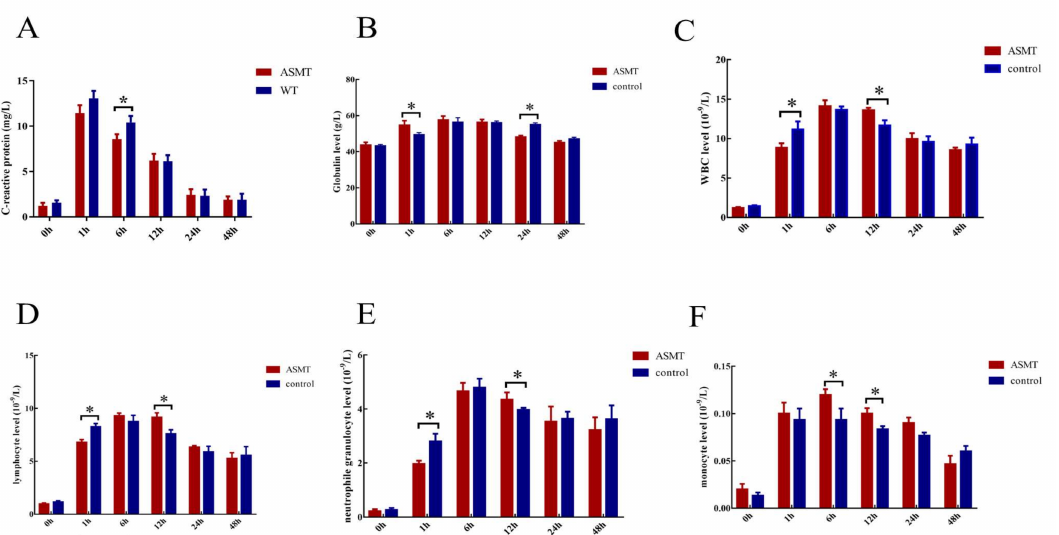
Figure 5. The effects of E. coli injection on the biophysiological indexes in transgenic (ASMT) and WT goats. ( A ) C-reactive protein content; ( B ) globulin content; ( C ) white blood cell content; ( D ) lympho- cyte content; ( E ) neutrophil content; ( F ) content of monocyte macrophages. * represents significant differences between the two groups.